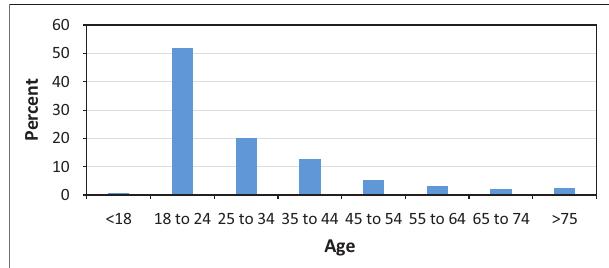
FIGURE 1: Age groups for tuk-tuk users.